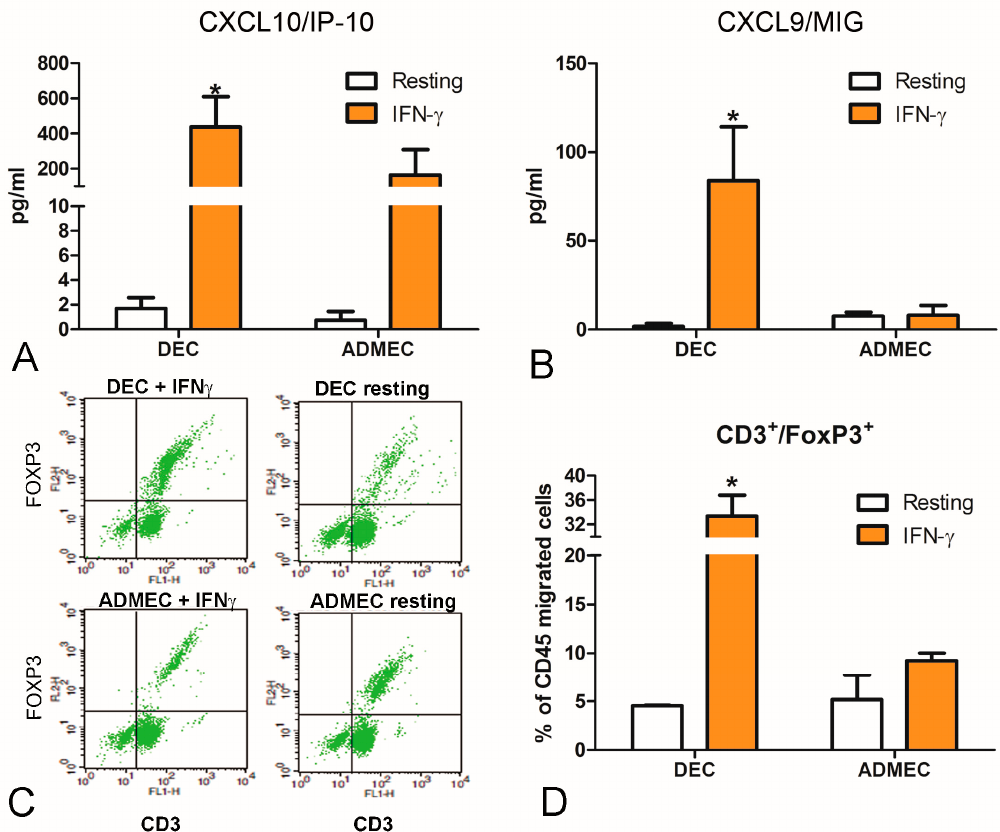
Figure 5. Secretion of chemokines and trans-endothelial migration of LM through EC stimulated with IFN- γ . The production of CXCL10/IP-10 ( A ) and CXCL9/MIG ( B ) in DEC and ADMEC supernatants after 4 h incubation with IFN- γ was measured using a beads-based multiplex immunoassay (Luminex ® ). The data represent the mean ± SD of triplicate samples from five separate experiments * p < 0.01. ( C , D ) Trans-endothelial migration of LM across untreated and IFN- γ -treated DEC and ADMEC. ( C ) Representative dot plots for flow cytometry of trans-endothelial migrated LM, stained for CD3 and FoxP3. ( D ) Quantitation of the percent of total migrated LM cells, positive for both CD3 and FoxP3 (CD3 + FoxP3 + ) by flow cytometry. Migration was presented as the percentage of CD45 migrated cells. The data represent the mean ± SD of duplicate samples from three separate experiments * p < 0.05.